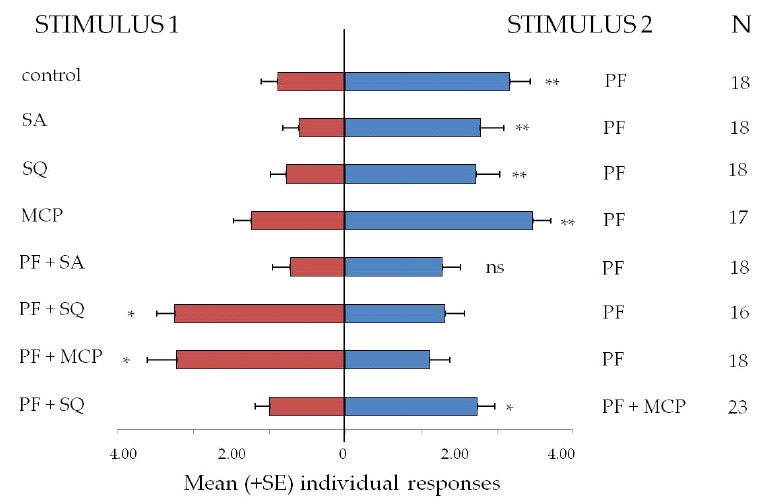
Figure 4. Necrobia rufipes adult responses (mean + SE) in dual-choice arena toward the stimuli tested inside the traps and their combinations. Control = empty; PF= pet food; MCP = methylcyclopentenolone; SQ = squalene; SA = stearic acid; N = number of responders; * = p < 0.05; ** = p < 0.01.